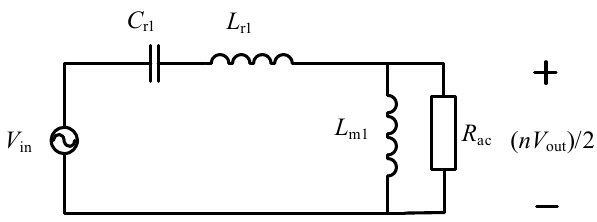
Figure 10. Equivalent circuit diagram of LLC resonant tank.